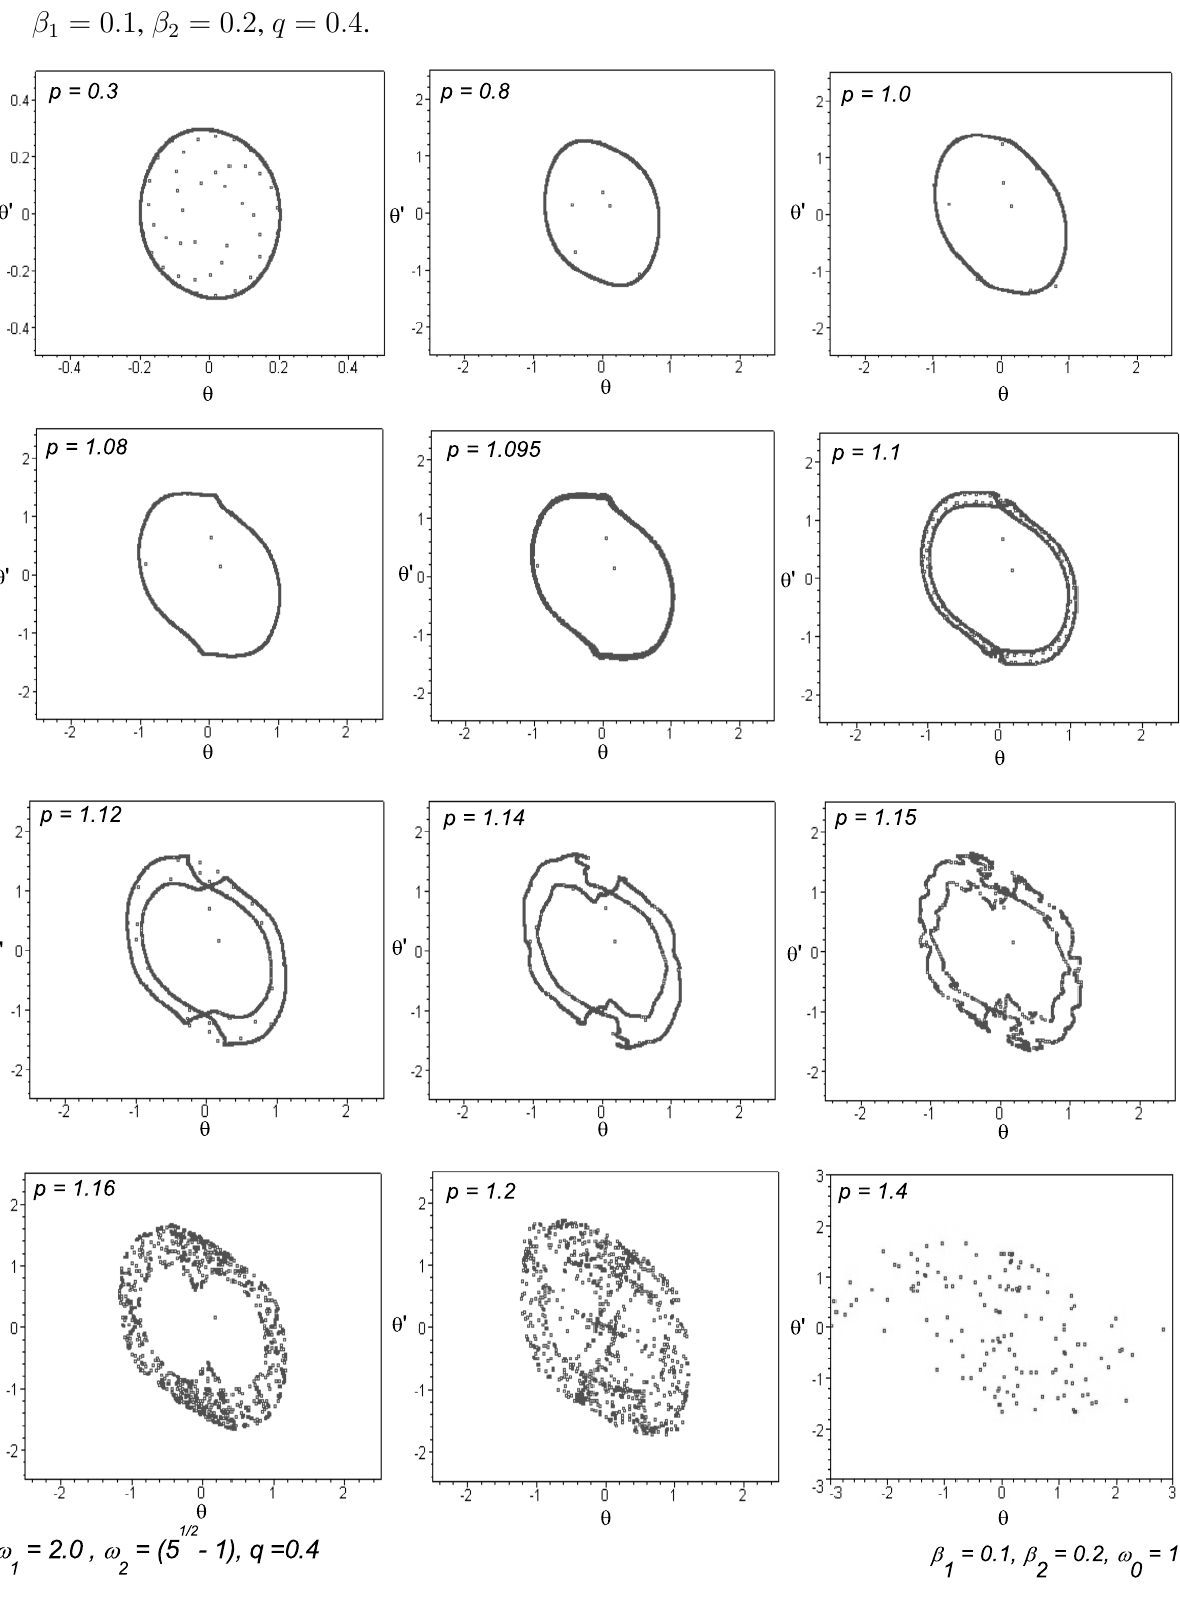
for a range √ ω 2 = 2 , ω = ( 5 − 1) , ω = 1 , 1 2 0